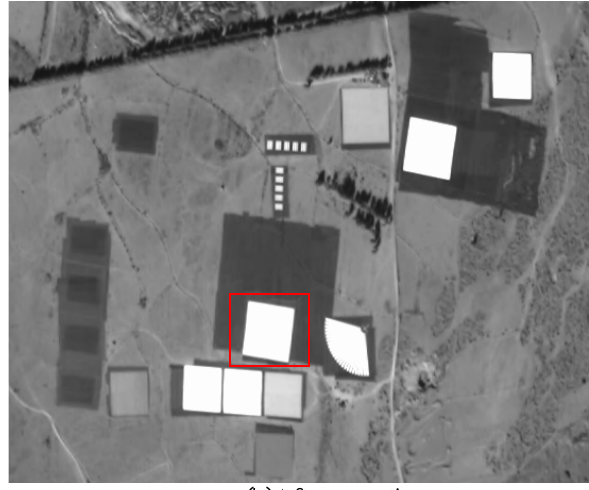
Figure 4. The image with targets before and after sensor